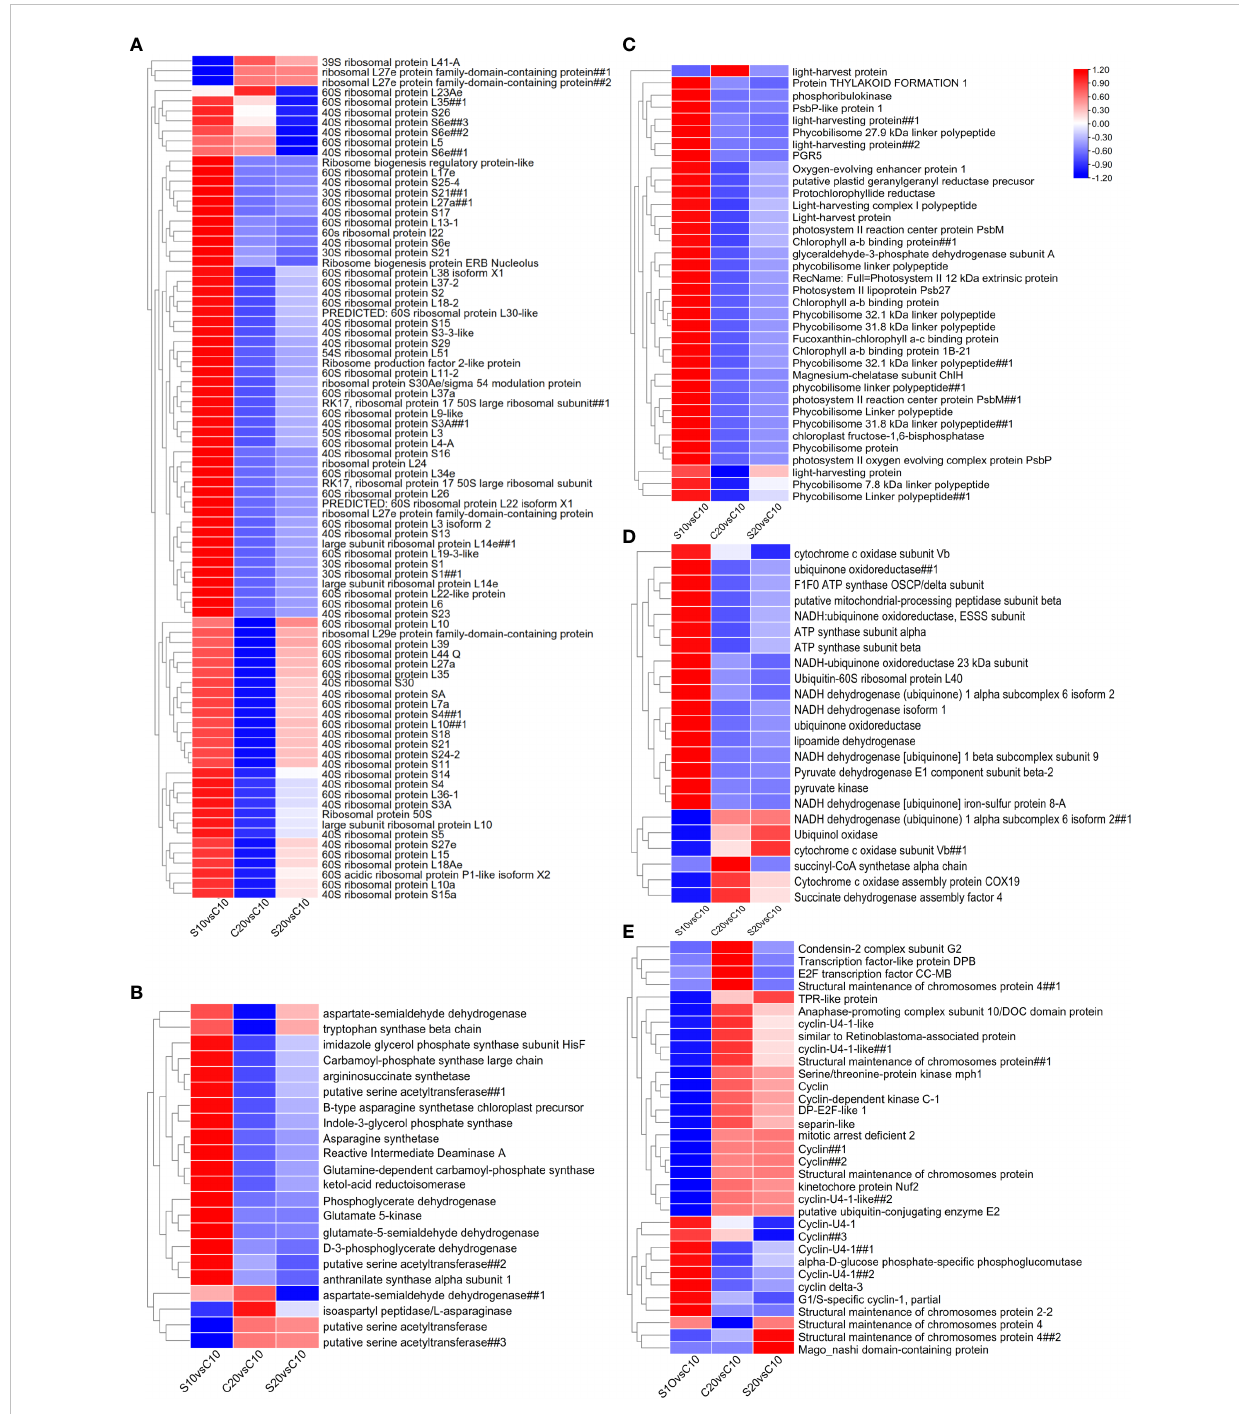
FIGURE 2 Heatmap showing the expression of DEGs related to (A) ribosome, (B) amino acid metabolism, (C) photosynthesis, (D) respiration and (E) cell cycle in S10, C20 and S20 groups. Due to some extremely high and low values, the expression data was scaled in each row to better illustrate the trend of gene expression in different groups. The symbols ## were used to distinguish different genes with same annotation in the